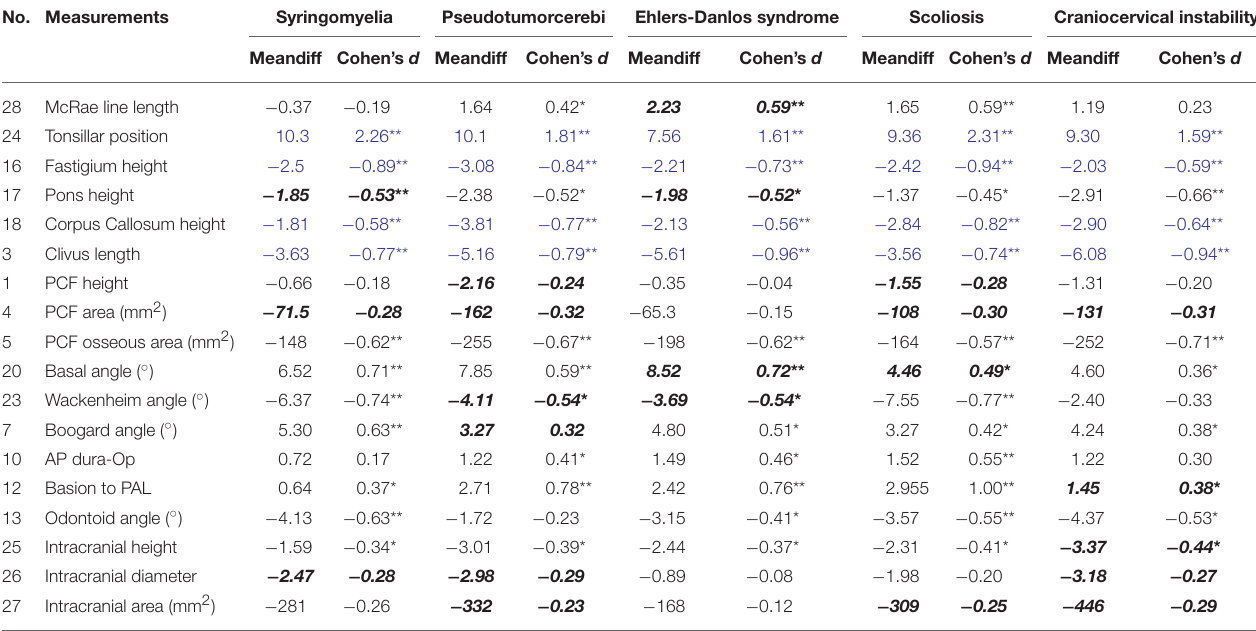
TABLE 4 | Descriptive statistics for comparison of CMI participants with related conditions and control